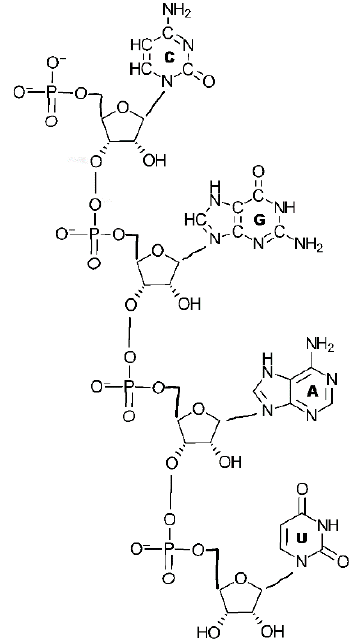
Figure 1. A fraction of the long chain of RNA, ribonucleic acid, showing the ‘back-bone’ of phosphate groups and ribose. The ribose binds to the phosphate in two positions (C (3) and C (5)) and to one out of four nucleobases in the C (1) position.